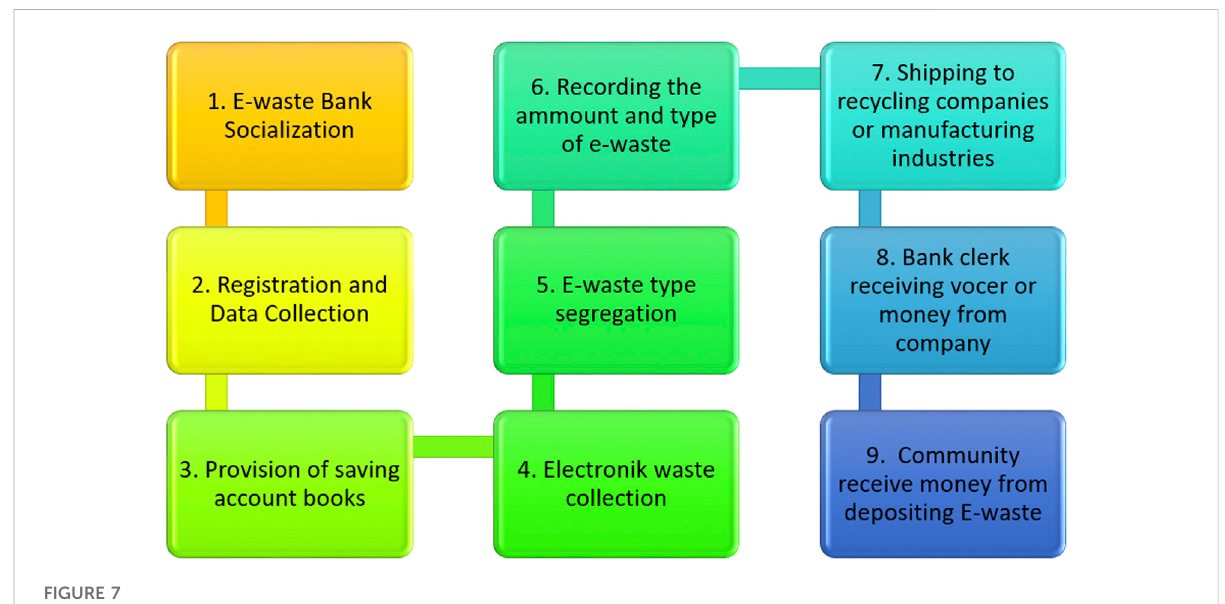
FIGURE 7 Mechanism of waste management in electronic waste